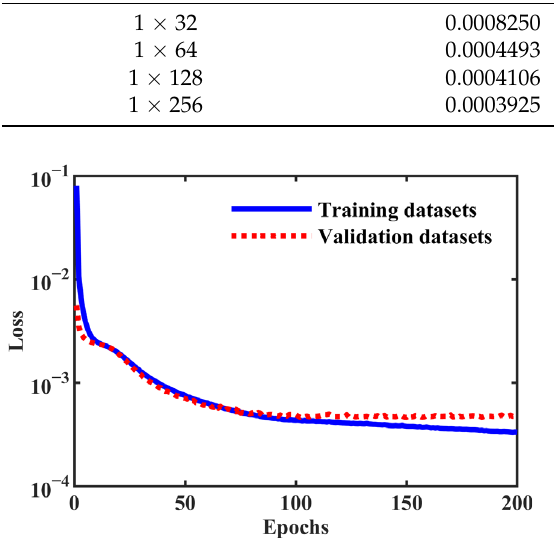
Table 3. The validation dataset loss and the training running time with different window sizes. Window Sizes